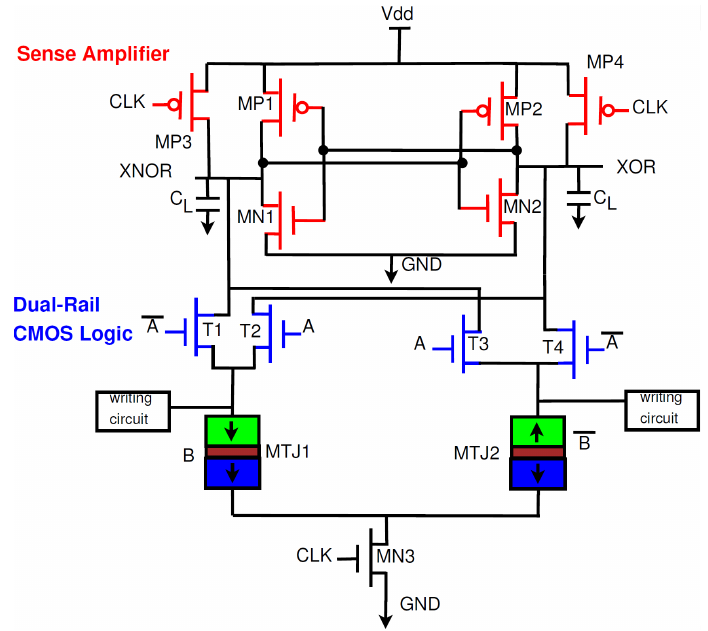
Figure 6. Hybrid CMOS-MTJ XOR circuit